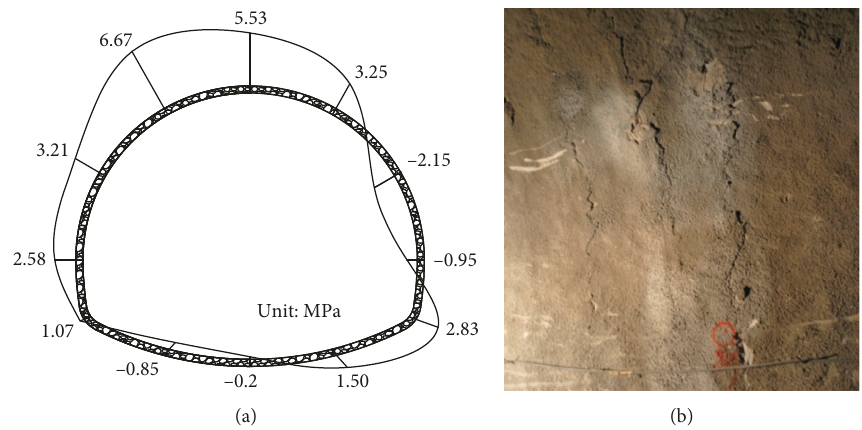
Figure 14: (a) Finally stress distribution of shotcrete and (b) cracking of the primary support.